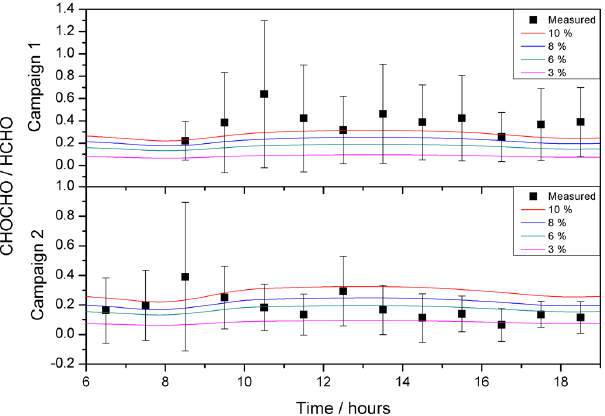
Fig. 13. The glyoxal/formaldehyde ratio between 06:00 and 19:00LT from the LP-DOAS measurements (black) and from the model using branching ratios for the yield of glyoxal from the OH+isoprene reaction of 3, 6, 8 and 10%, for each of the OP3 campaigns.